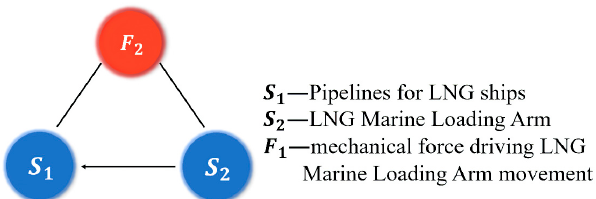
Figure 13. The Su- fi eld model of the problem. Figure 13. The Su-field model of the problem.